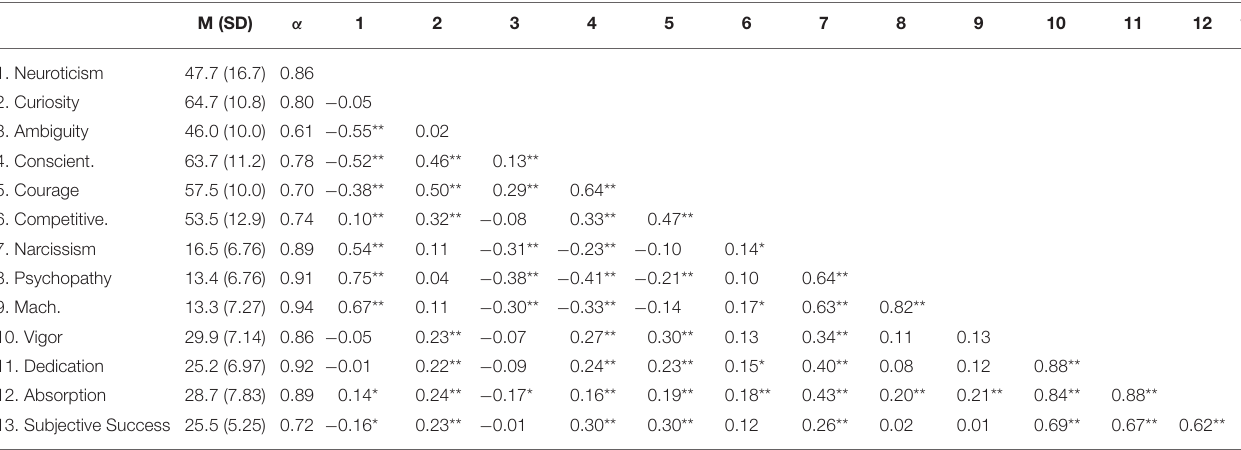
TABLE 2 | Correlations between HPTI, Dirty Dozen, UWES subscales, and Subjective